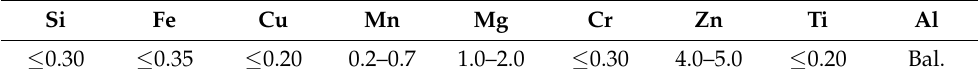
Table 1. Chemical compositions of 7N01 (wt.%).